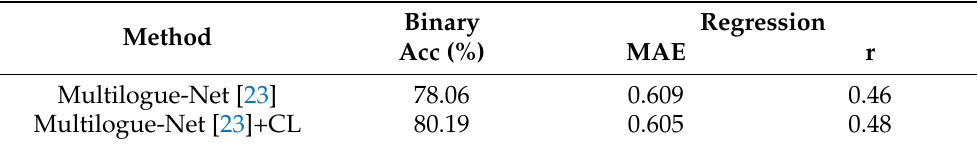
Table 2. CMU Multimodal Opinion Sentiment and Emotion Intensity (CMU-MOSEI) experiment results. All the results are reproduced. CL: correspondence learning. MAE: Mean Absolute